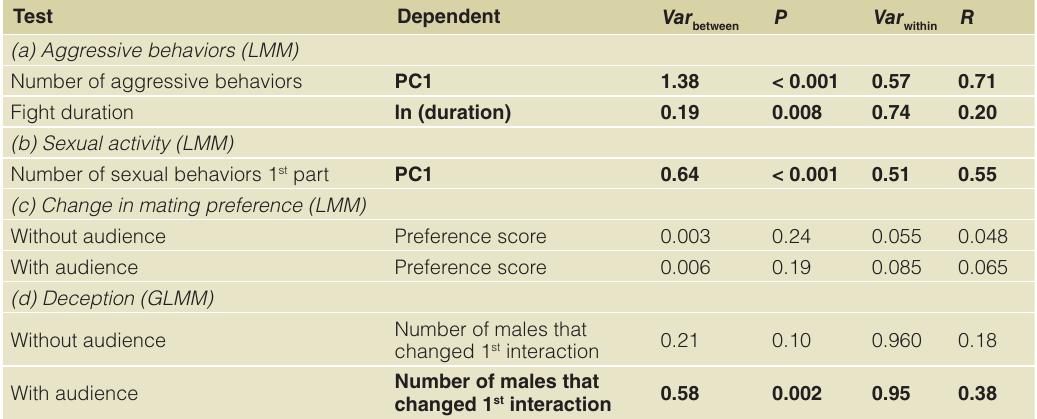
) and within-species variances ( Var between within